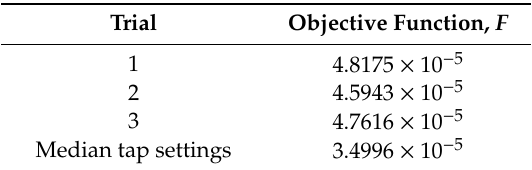
Table 3. Final objective function for each trial and the objective function of the median tap settings in Case 1.2.